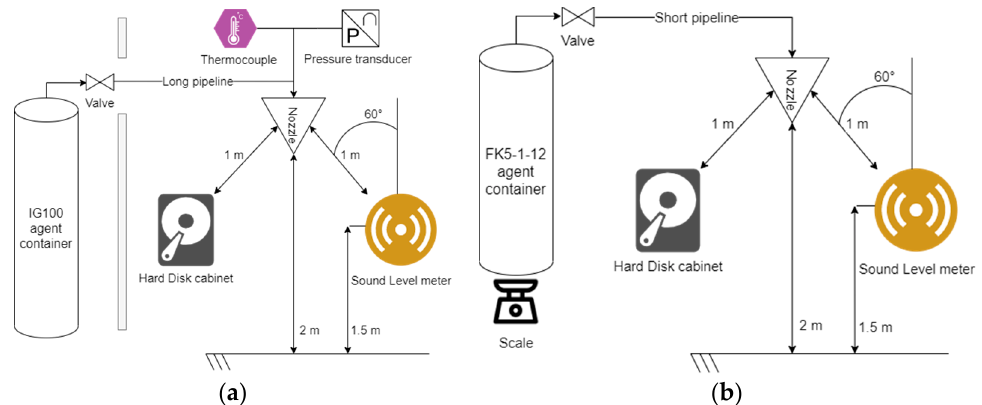
Figure 1. Schematic of the realized setup to evaluate acoustic performance by supplying ( a ) nitrogen IG100 or ( b ) FK-5-1-12.